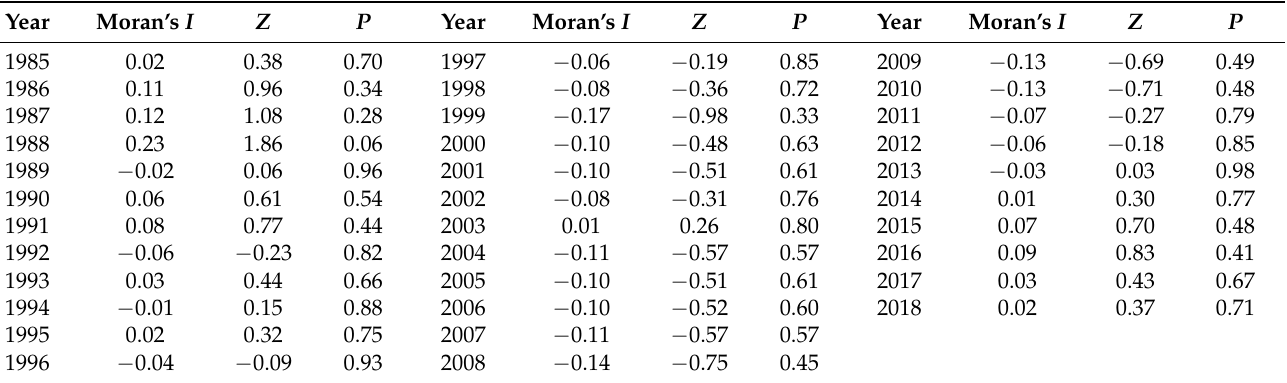
Table 1. Global Moran’s I for the period 1985–2018.